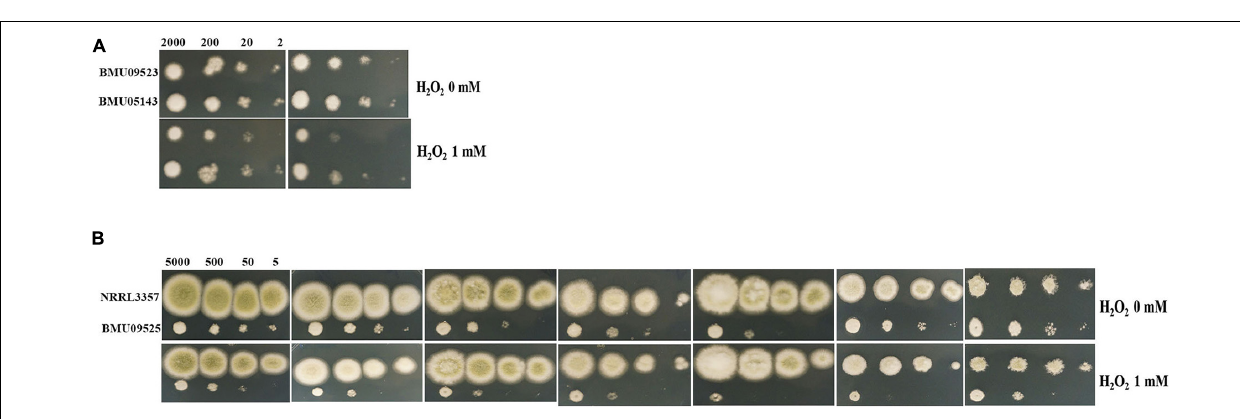
FIGURE 2 | The sensitivity to H 2 O 2 determined by spot assay. Hydrogen peroxide (H 2 O 2 ) at a concentration of 1 mM was supplemented in PDA medium with or without antifungal drugs. (A) A total of 2, 20, 200, and 2 × 10 3 conidia of A. terreus were spotted onto PDA medium, respectively. (B) A total of 5, 50, 500, and 5 × 10 3 conidia of A. flavus were spotted onto PDA medium, respectively. Plates were incubated at 35 ◦ C and documented after 48